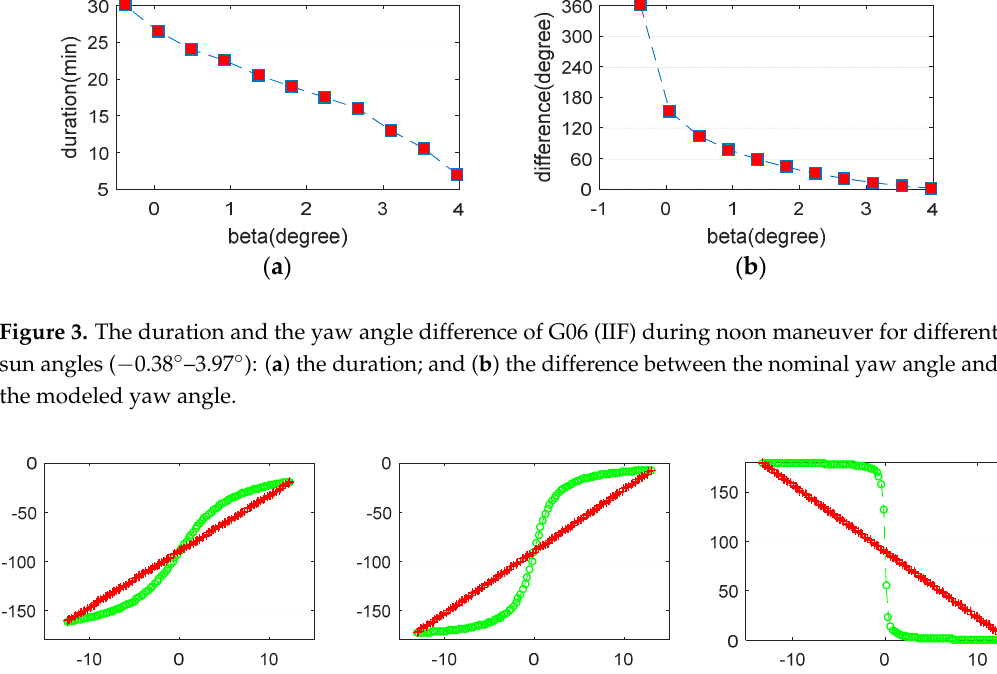
Figure 3. The duration and the yaw angle difference of G06 (IIF) during noon maneuver for different sun angles ( − 0.38°–3.97°): ( a ) the duration; and ( b ) the difference between the nominal yaw angle and the modeled yaw angle.